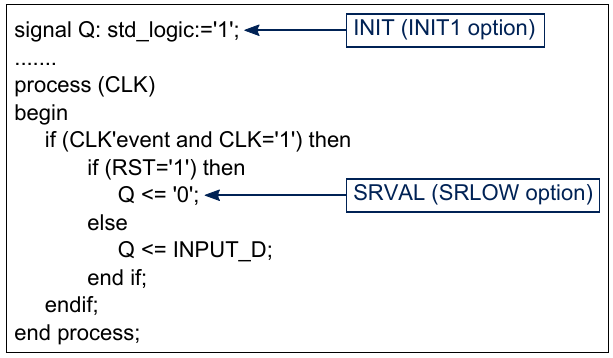
Figure 2. VHDL code example of a flip-flop with INIT and SRVAL